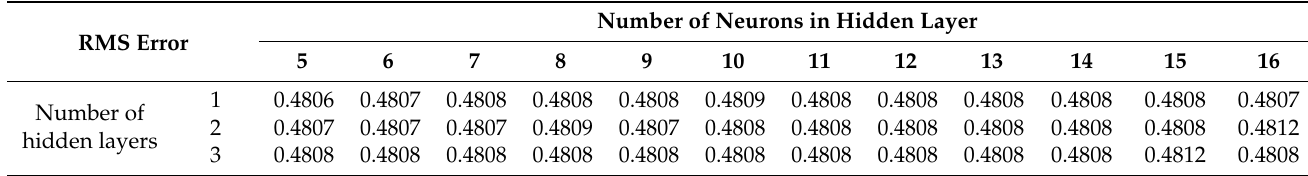
Table 12. RMS error for active power loss estimation for IEEE-13 bus